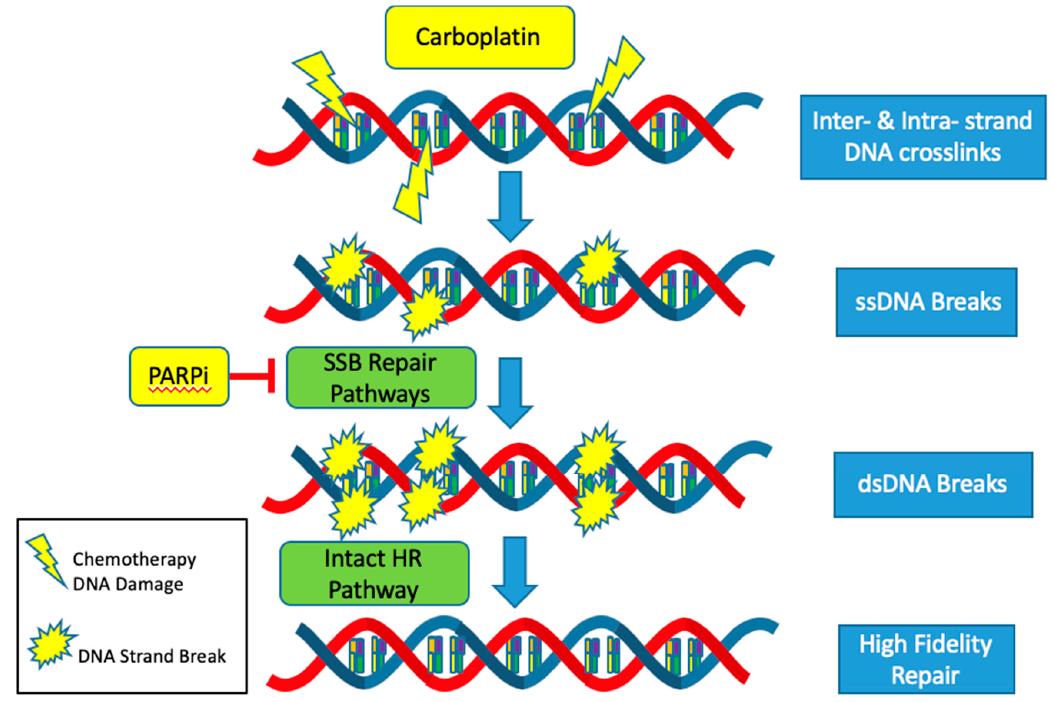
Figure 3. Schematic representation of the mechanism of CCNE1 amplification resistance to front-line cytotoxic (Carboplatin) and targeted (PARP Inhibitors) ovarian cancer chemotherapies.